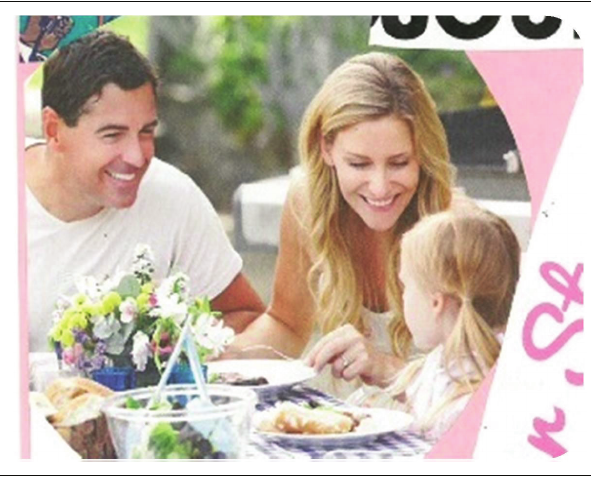
FIGURE 2: Family and social